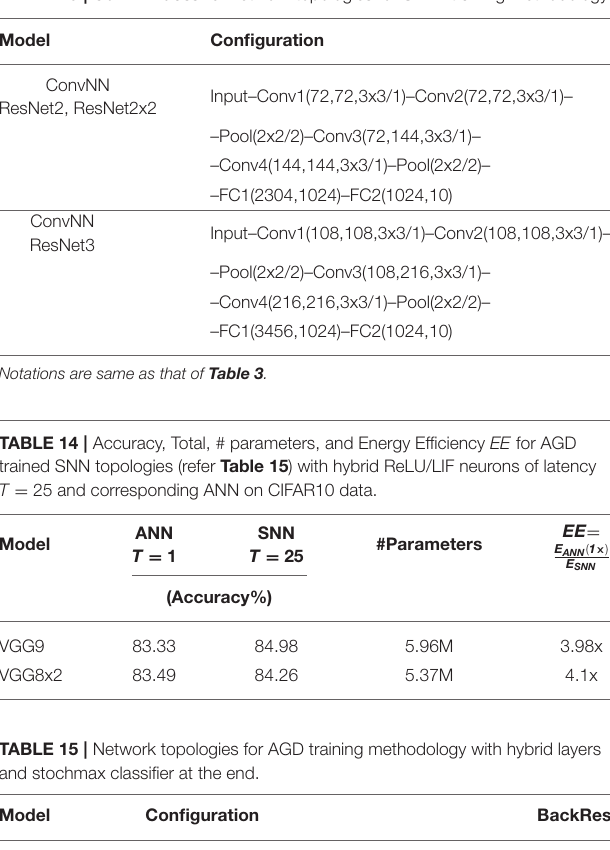
TABLE 13 | ConvNN classifier network topologies for STDP training methodology.